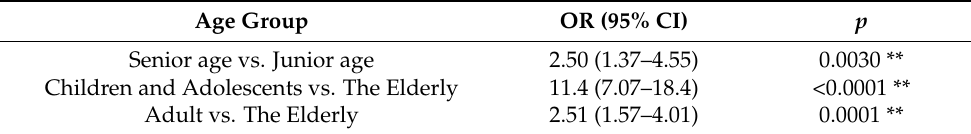
Table 4. Relative risk of sexual assault victims (by